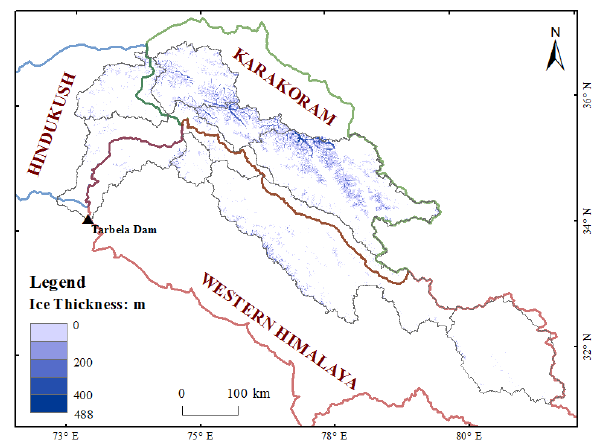
Figure 5. Spatial heterogeneity distribution of ice thickness of the entire